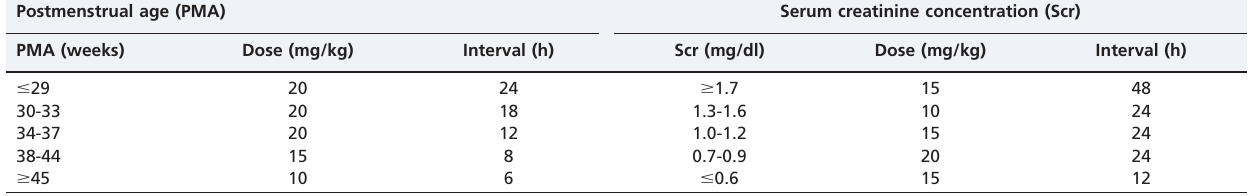
Table 2 - Two neonatal vancomycin dosing strategies (postnatal age , 60 days) developed by Capparelli et al. (11). Postmenstrual age